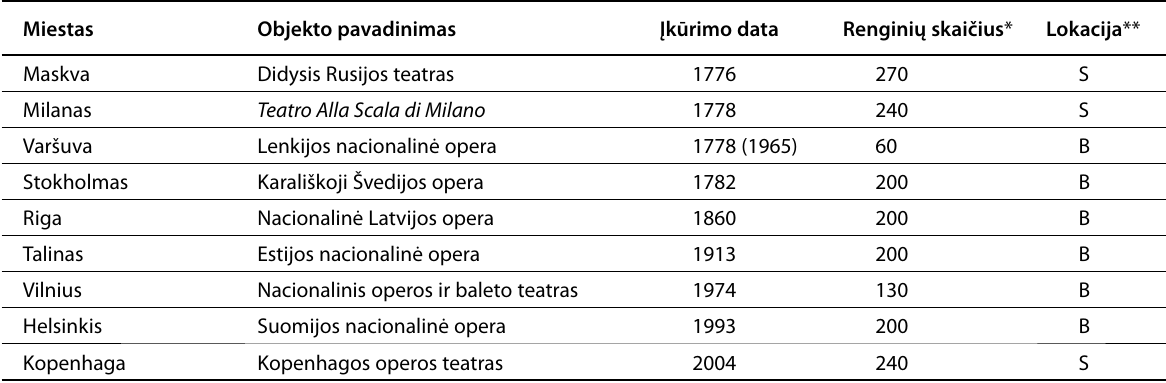
Table 2. The location and event production of Opera houses in Italy and the baltic Sea region